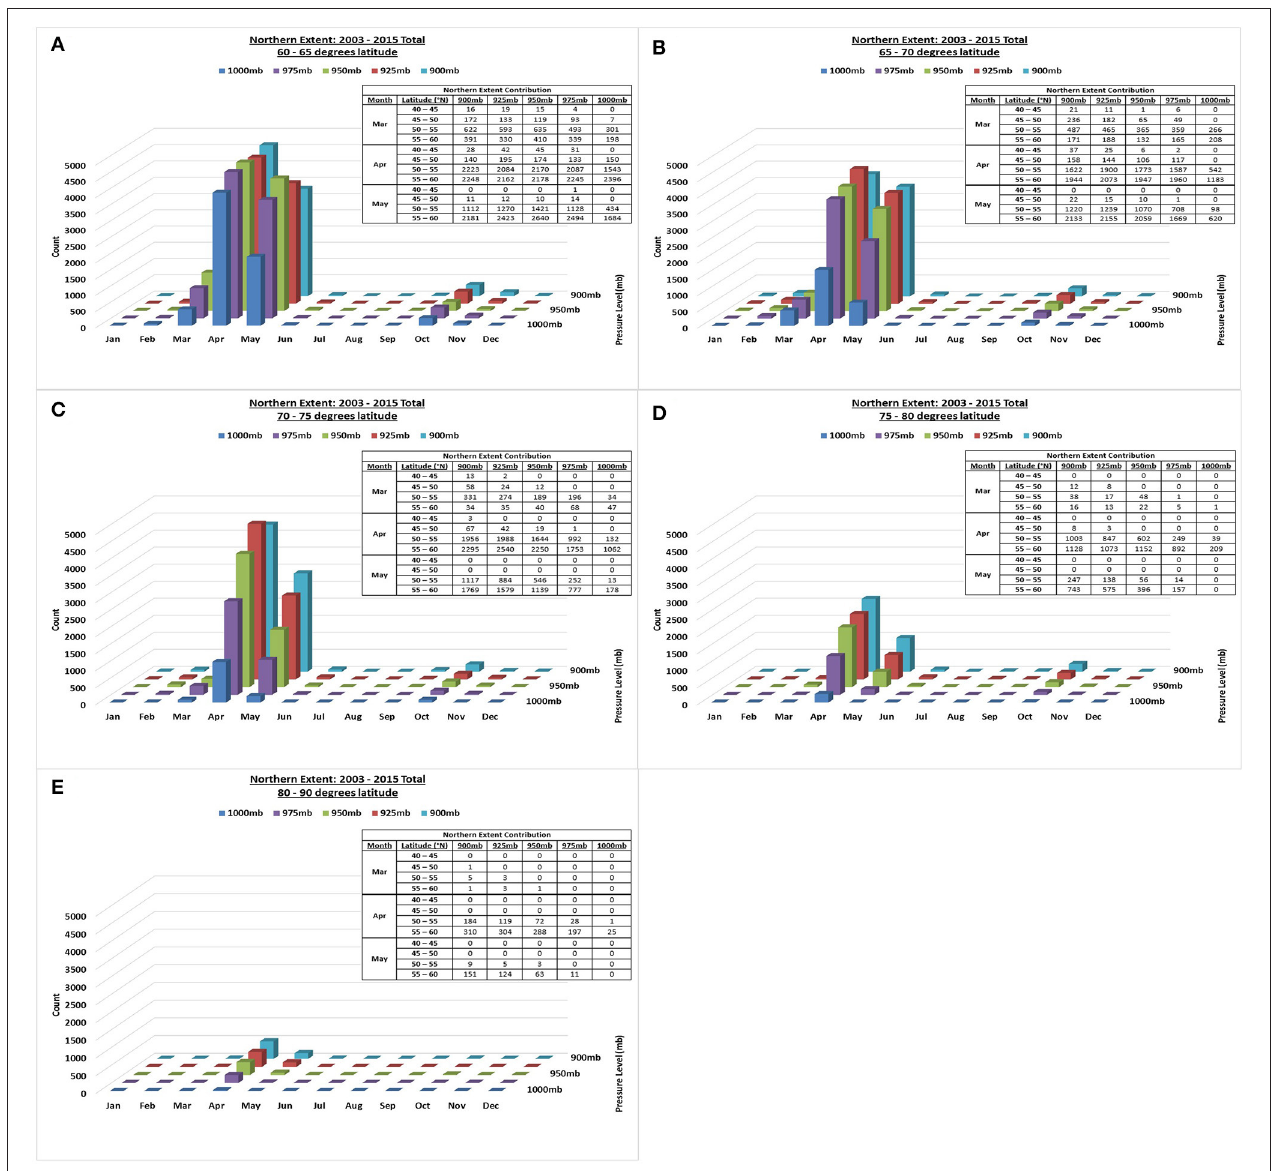
FIGURE 5 | Total number of successful events (monthly) between 2003 and 2015 that reach snow cover between 60–65 ◦ N (A) , 65–70 ◦ N (B) , 70–75 ◦ N (C) , 75–80 ◦ N (D) , 80–90 ◦ N (E) as their northern-most extent per injection height. The inset table represents the contribution from the lower latitude bands (40–45 ◦ N, 45–50 ◦ N, 50–55 ◦ N, 55–60 ◦ N) for March, April and